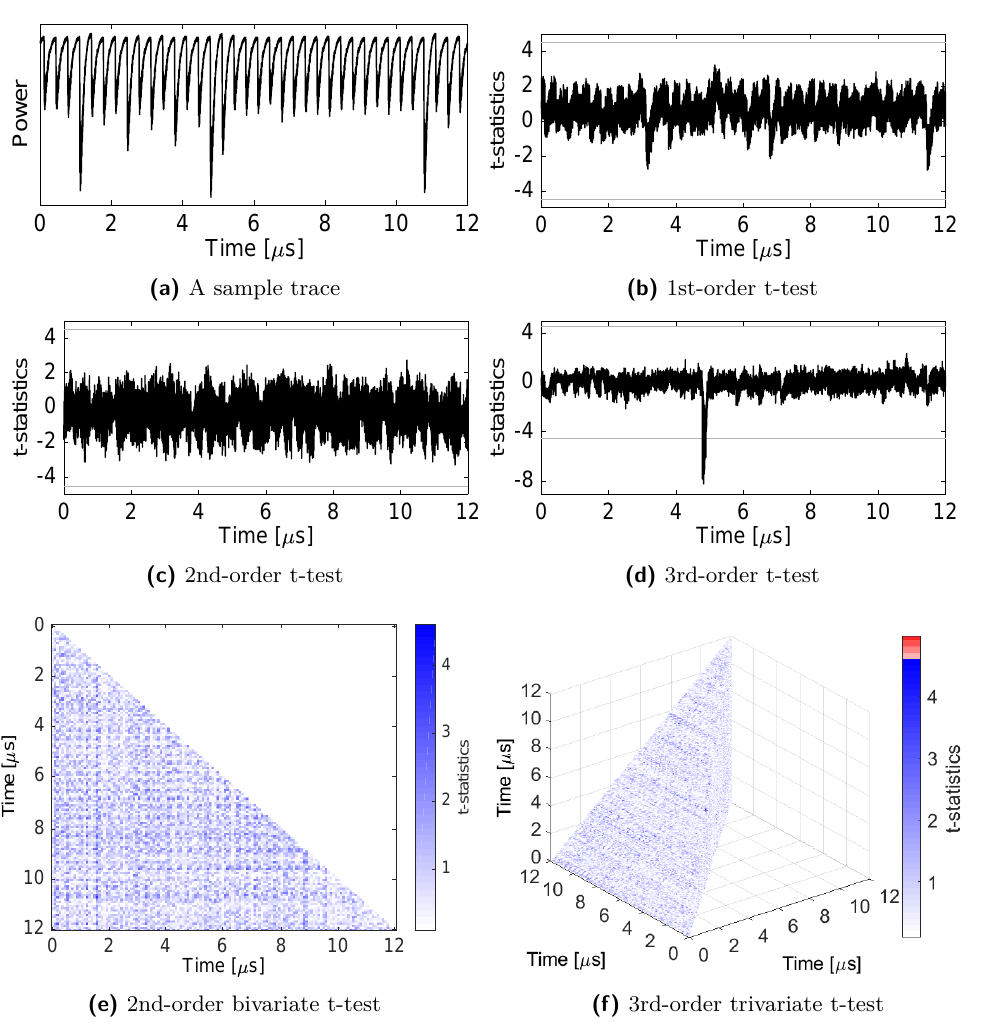
Figure 7: Experimental analysis of our masked Prince using 100 million